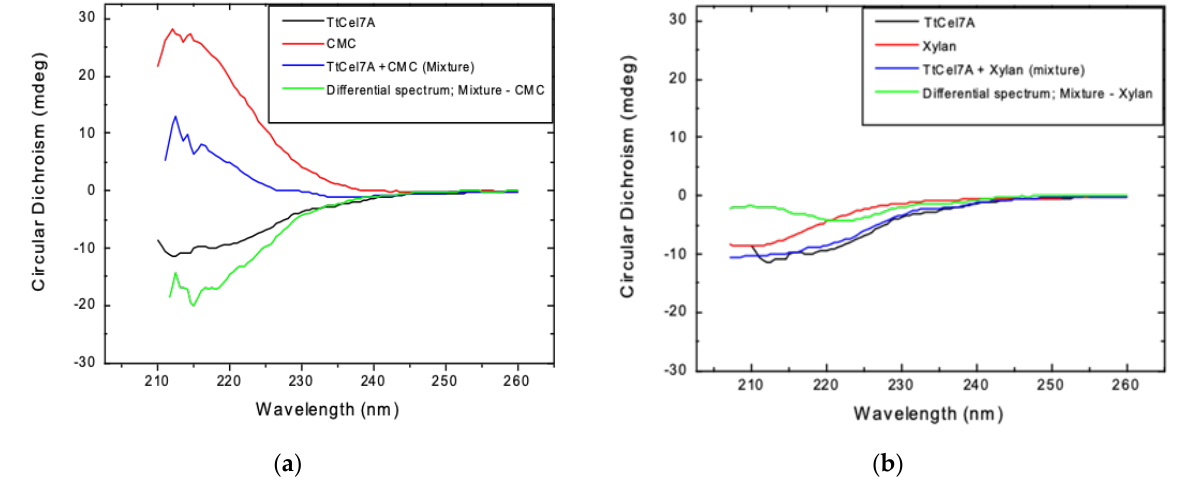
Figure 6. ( a ) Far-UV CD spectra of the purified TtCel7A, CMC, or TtCel7A+CMC mixture and ( b ) TtCel7A, beechwood xylan, or TtCel7A+ beechwood xylan mixture were measured using a JASCO J-815 spectropolarimeter (Jasco Inc., Easton, MD) equipped with a PFD-425S Peltier-type cell holder for temperature control and magnetic stirring. Scans were taken between 200 and 250 nm, at a scan rate of 10 nm min −1 using a 1.0 cm path-length cuvette. Buffer baselines were subtracted from all spectra.